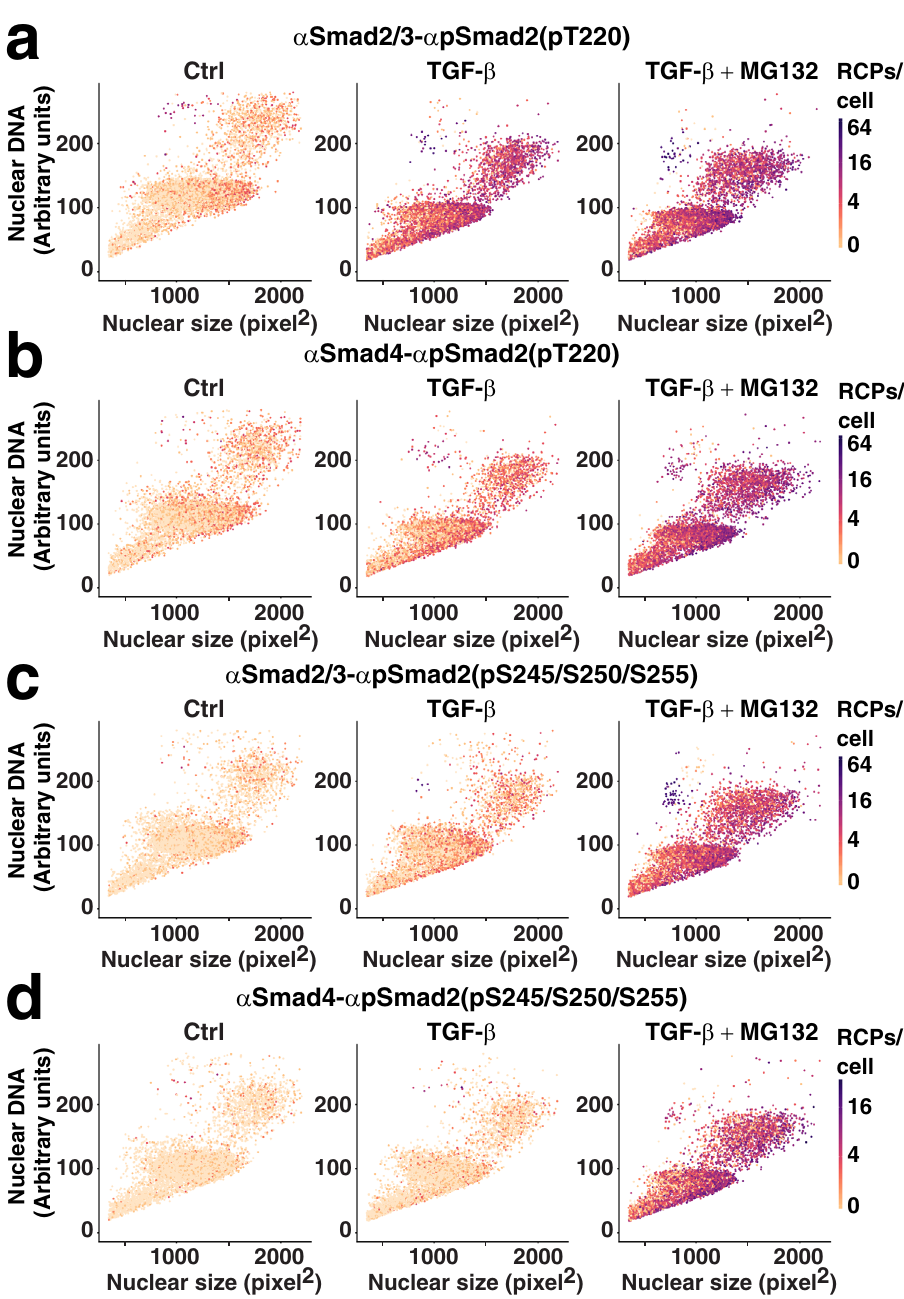
Fig. 3 Smad2 linker phosphorylation and complex formation in response to TGF- β and the proteasomal inhibitor MG132. HaCAT cells were starved and untreated, treated with 10 ng/ml TGF- β for 6 h, or treated with 10 ng/ml TGF- β and 25 μ M MG132 for 6 h before fi xation, isPLA, and imaging. Individual cells were color-coded according to the numbers of RCPs/cell for a Smad2/3-Smad2(pT220), b Smad4-Smad2(pT220), c Smad2/3-Smad2(pS245/ pS250/pS255), and d Smad4-Smad2(pS245/pS250/pS255). The cells were plotted according to the area of the nuclear stain along the X axes (pixels 2 (~0.11 µ m 2 )) and the integral intensity of the DNA stain along the Y axes. The log2 color scales indicate 0 – 64 RCPs/cell for a – c and 0 – 32 RCP/cell for d